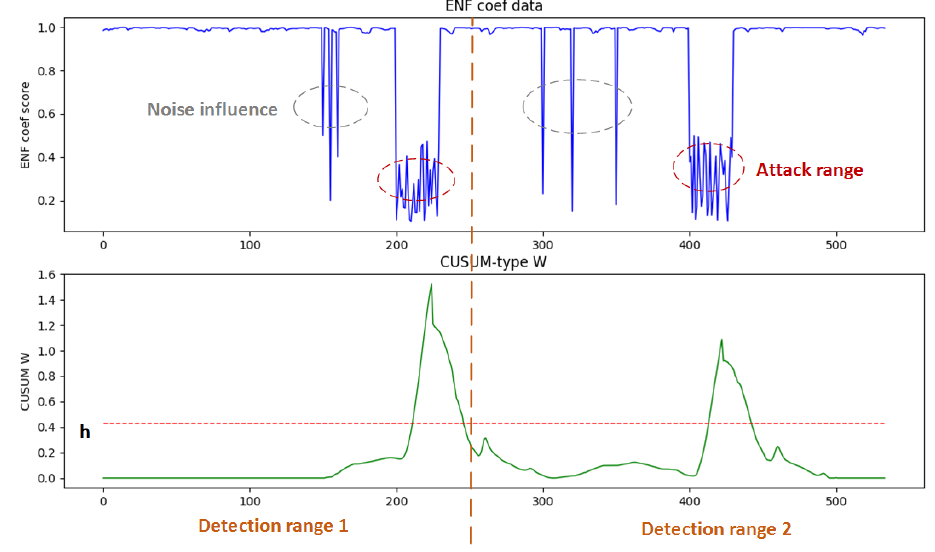
Figure 8. The SSA detection on deepfake attack